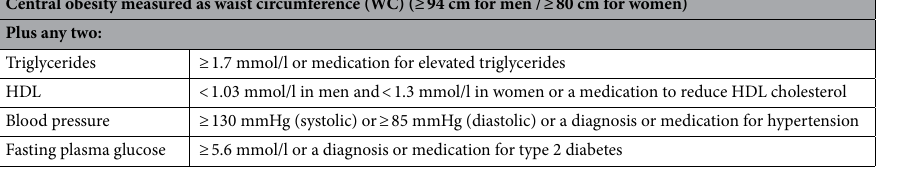
Table 2. Definition of metabolic syndrome (MetS) according to the International Diabetes Federation (IDF). HDL high-density lipoprotein.